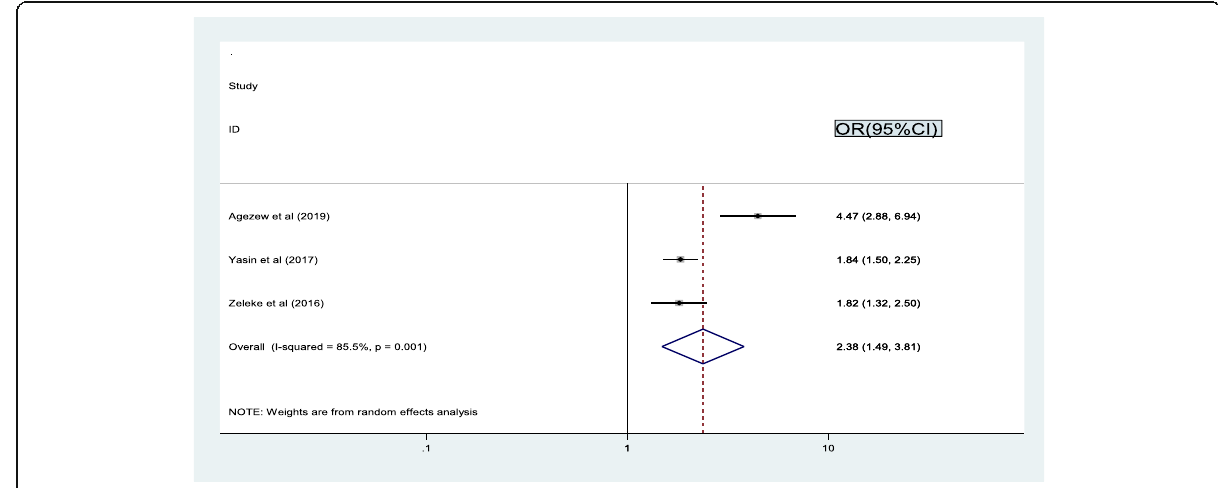
Fig. 5 Pooled odd ratio between advanced WHO clinical stage and treatment failure